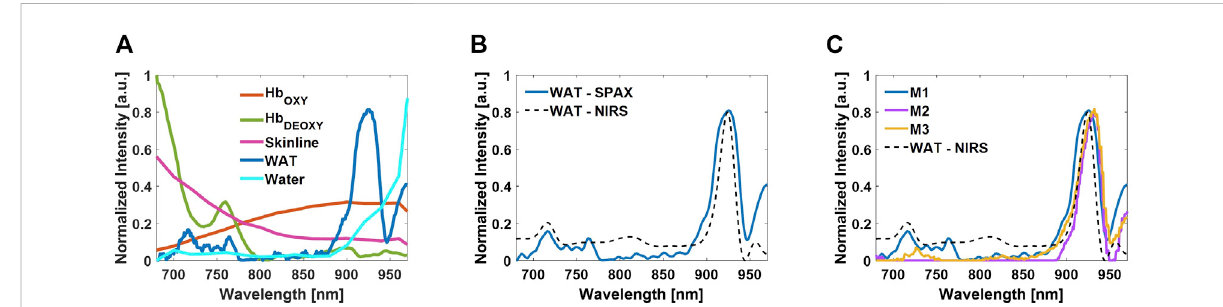
FIGURE 7 Tissue componentspectra unmixed bythe SPAX from the cervical-thoracicarea of themouse invivo . Oxygenated hemoglobin, deoxygenated hemoglobin, skinline, WAT, and water are the identi fi edcomponents from the seven source components (A) . Comparison betweenthe spectrum of WAT extracted by SPAX and the WAT absorption spectrum measured via NIRS (B) . Comparison between the WAT spectrum extracted by SPAX from three different animals in vivo and the WAT absorption spectrum measured via NIRS (C) .